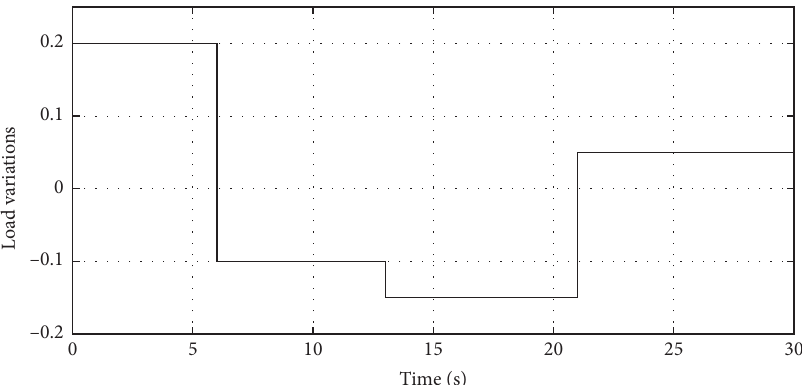
Figure 6: Stochastic attack.